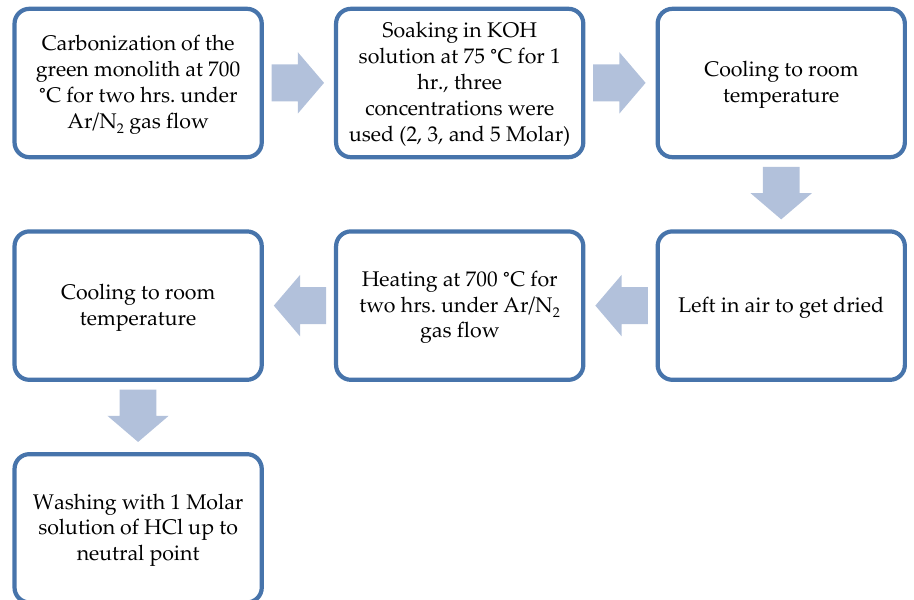
Figure 2. Steps of chemical activation of the composite green monolith.